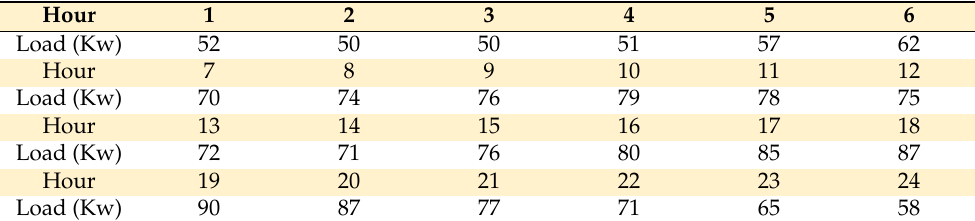
Table 2. Rate of daily loading.